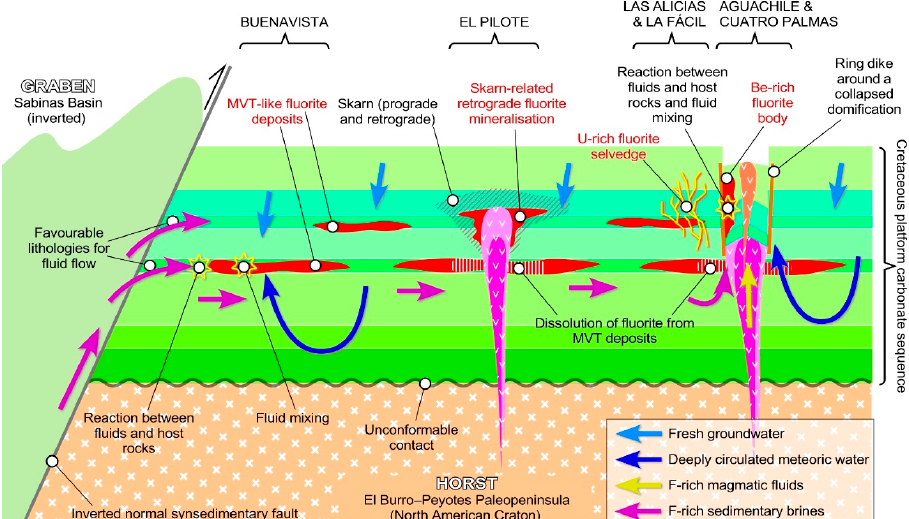
Figure 11. General genetic model for the formation of MVT-like, skarn, and shallow hydrothermal fluorite deposits in northern Coahuila (northeastern Mexico), and the related sources for fluids and elements that constitute the different deposits. See discussion for